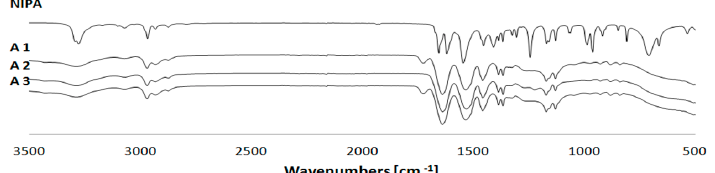
Figure 2. Fourier-transform infrared spectroscopy (FTIR) spectra of obtained A1–A3 particles and main monomer N -isopropylacrylamide (NIPA). The disappearance of vinyl bonds signals (3104, 3030, 1620, and 1409 cm − 1 ) confirms the insertion of the monomer into the polymer particle.